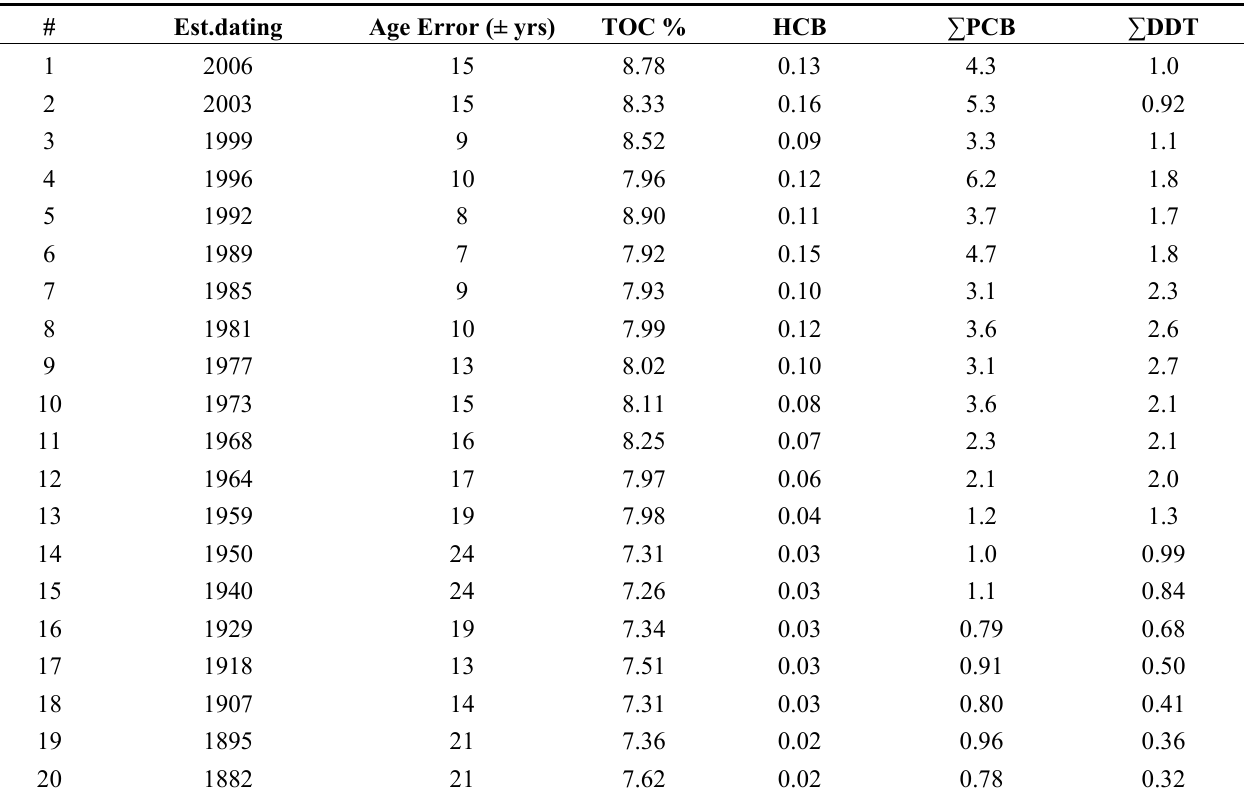
Table 1. Estimated dating, Total Organic Carbon (TOC) % values and Persistent Organic Pollutants (POP) concentrations (ng/g dw) for the sediment core collected in